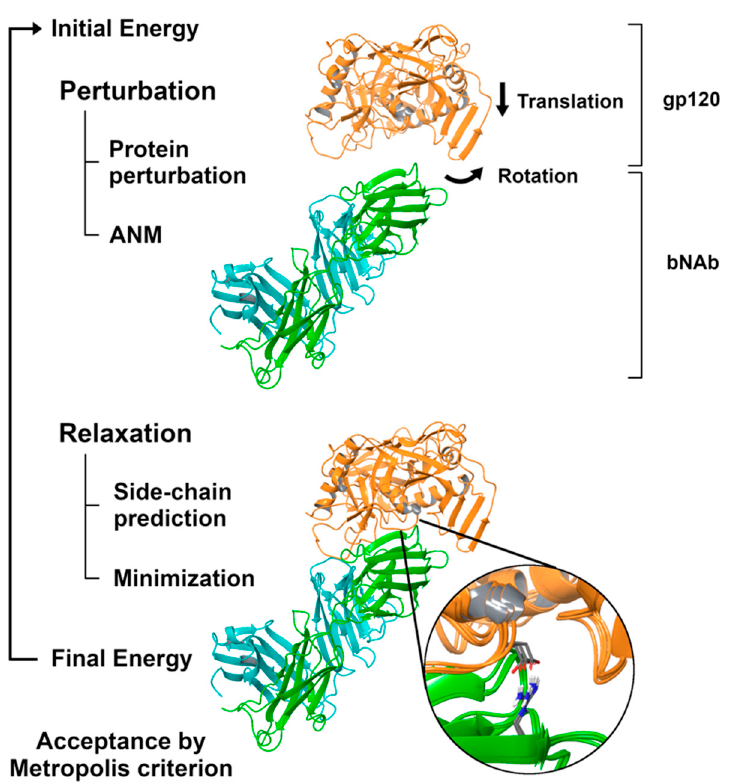
Figure 1. Graphical representation of a Protein Energy Landscape Exploration (PELE) step for protein–protein simulations. PELE consists of two phases: perturbation and relaxation. During the former, a protein is perturbed (random translations and rotations), and a sampling protocol based anisotropic network model (ANM) is performed to account for backbone motions. During the latter, a side-chain protocol and a minimization step are performed to generate energetically stable conformations. The entire movement is accepted according to a Metropolis criterion.